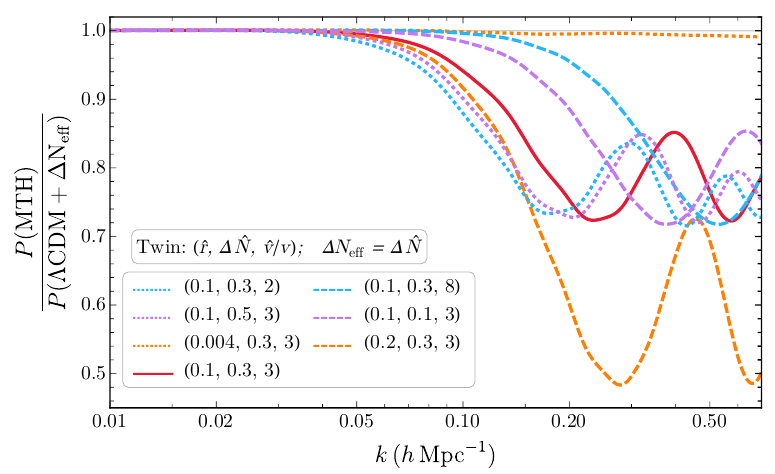
Figure 6. The linear matter power spectrum for the MTH model relative to that of the Λ CDM +∆ N model for various twin eff